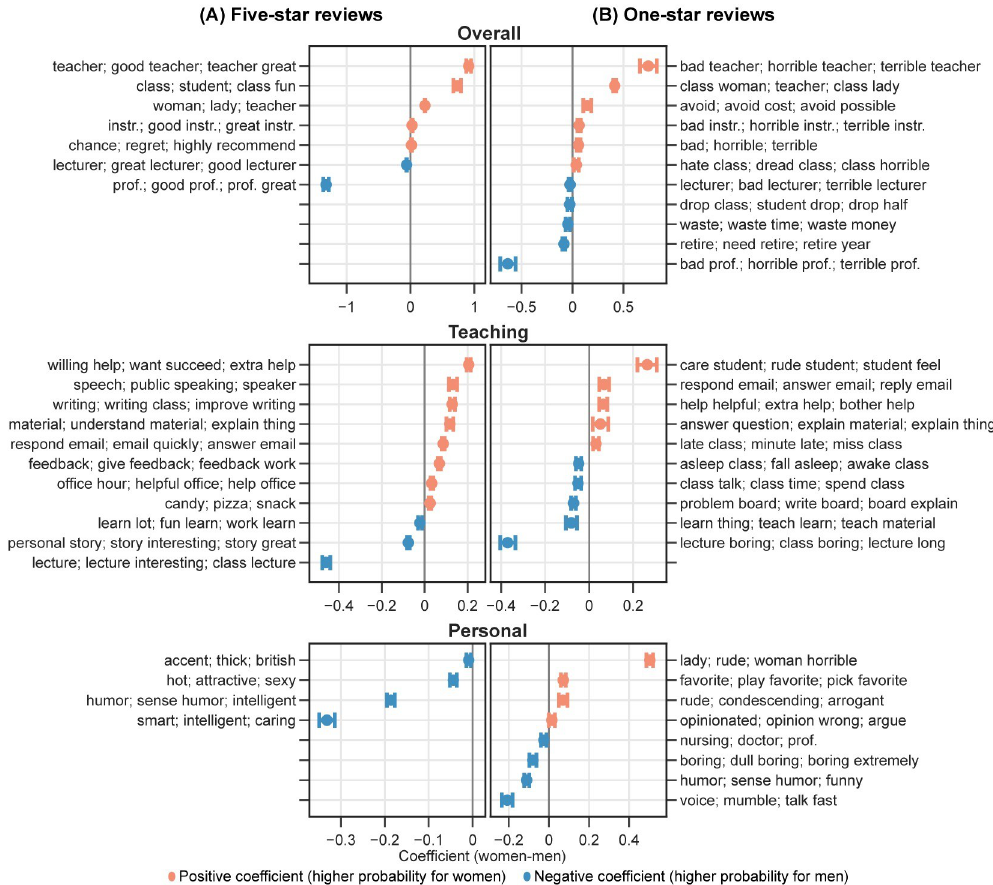
Fig 7. Regression analysis of predicted possibilities from topic modeling in (A) five-star and (B) one-star reviews by professor-level topic dimensions. An orange mark denotes a positive coefficient of gender (1 = women), meaning that the topic is more likely to appear in comments for women professors. A blue mark denotes a negative coefficient of gender, indicating that the topic is more likely to appear in comments for men professors. Only statistically significant results are shown. prof. = professor; instr. =